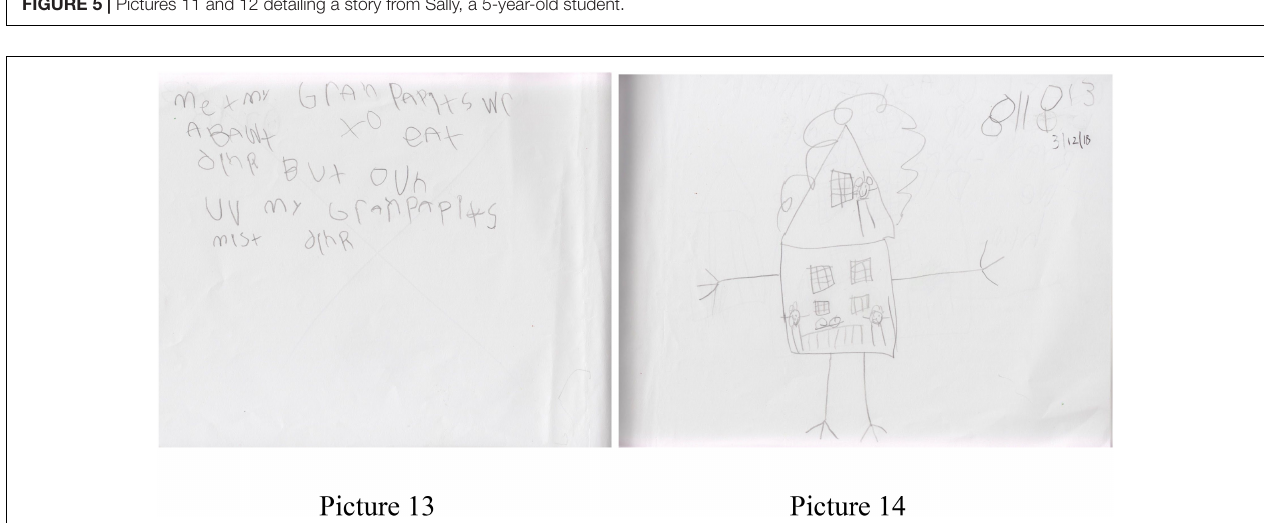
FIGURE 5 | Pictures 11 and 12 detailing a story from Sally, a 5-year-old student.